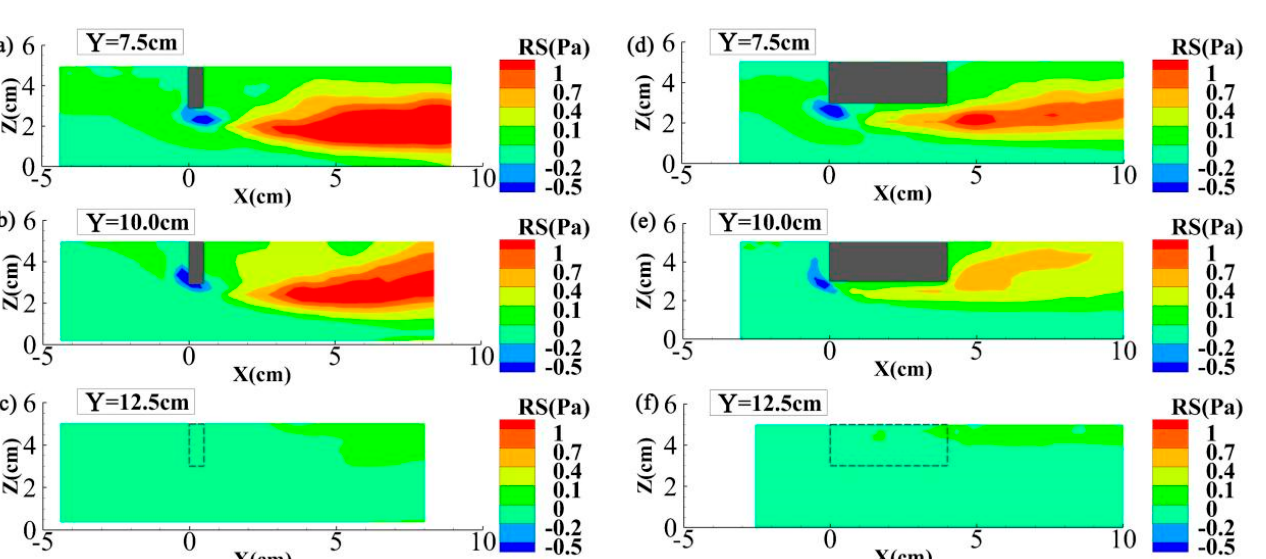
Figure 15. Distributions of vertical turbulent intensity at longitudinal sections ( a ) Y = 7.5 cm, ( b ) Y = 10.0 cm, ( c ) Y = 12.5 cm in Case 7 (on the left) and at longitudinal sections ( d ) Y = 7.5 cm, ( e ) Y = 10.0 cm, ( f ) Y = 12.5 cm in Case 8 (on the right). The grey areas in subfigures ( a ), ( b ), ( d ) and ( e ) demon- strate the floating dike, and the dotted lines in subfigures ( c ) and ( f ) indicate the location of floating dike in the coordinate system.